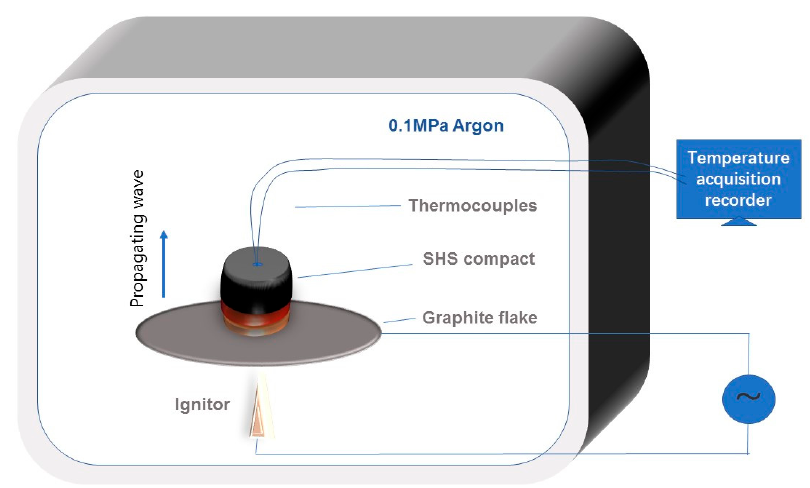
Figure 1. The schematic diagram of the SHS experimental apparatus.